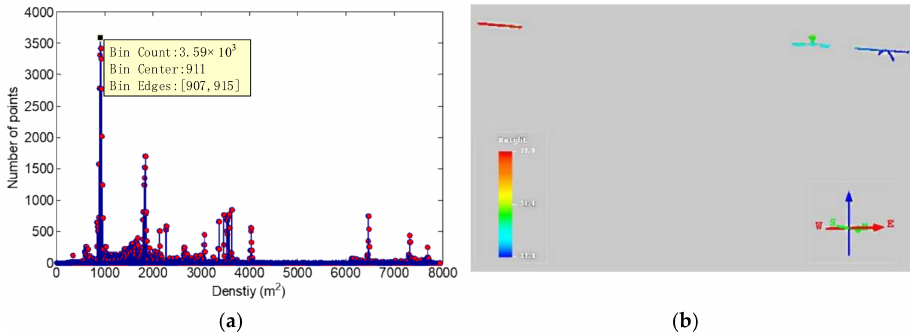
Figure 13. Density histogram of a partition in the second dataset ( a ) and corresponding extraction results ( b